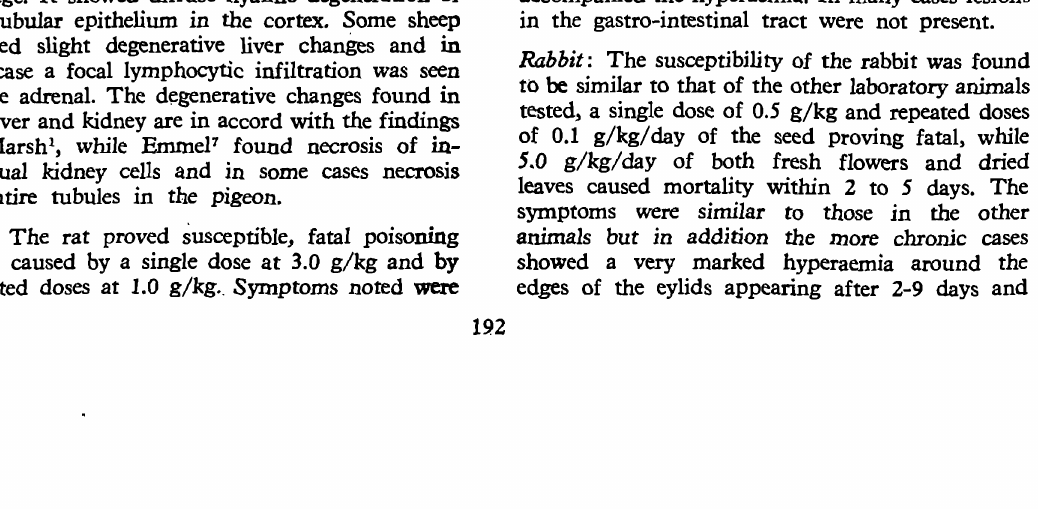
TABLE 2.-CHEMlCO-PAmOLOGICAL CHANGES IN SHEEP No.4 DOSED WITH FRESH